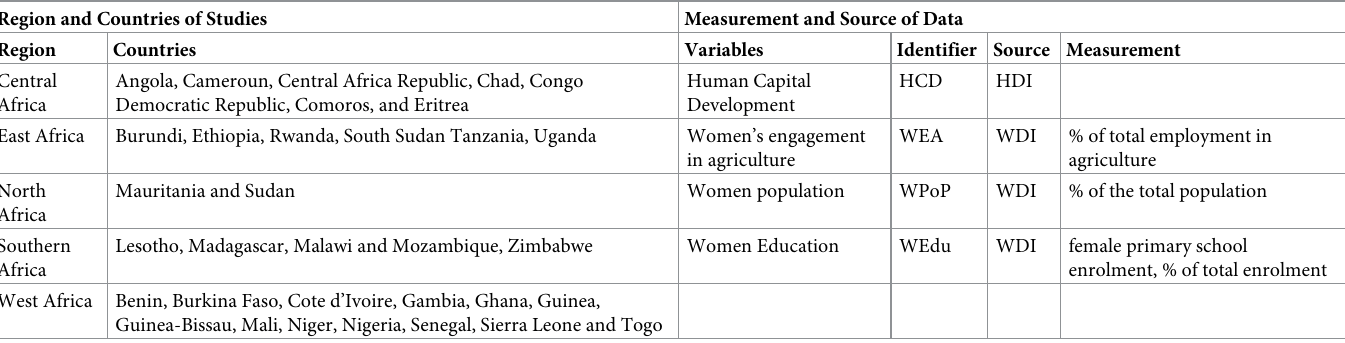
Table 1. Region of study and definition of